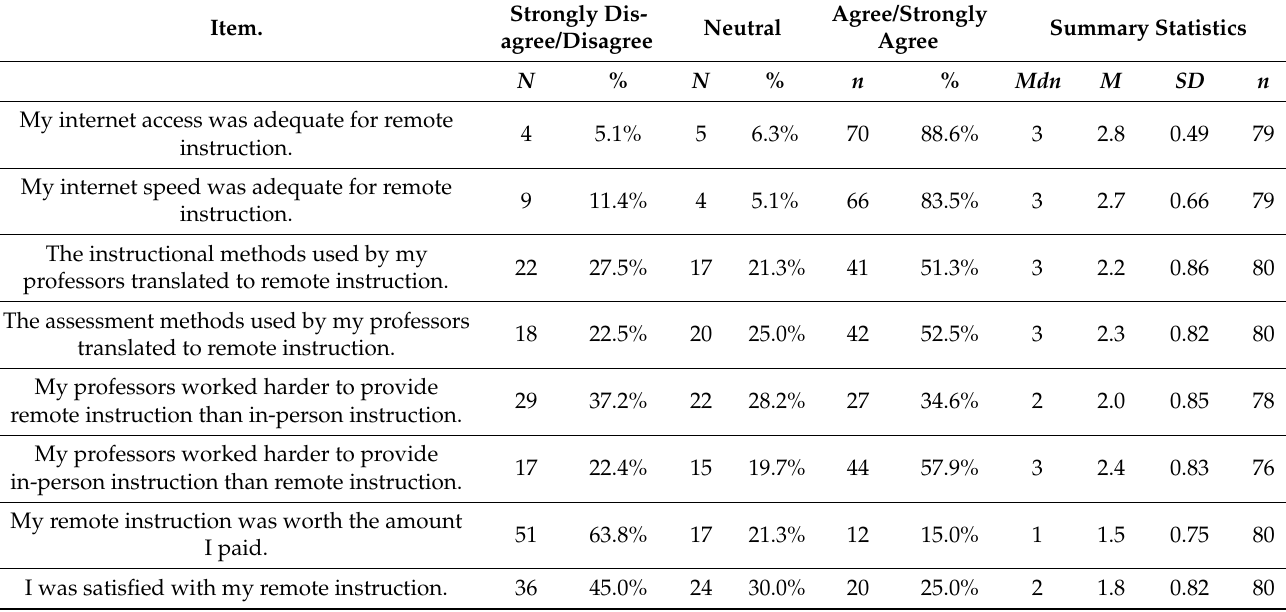
Table 4. Initial Perceptions about Remote